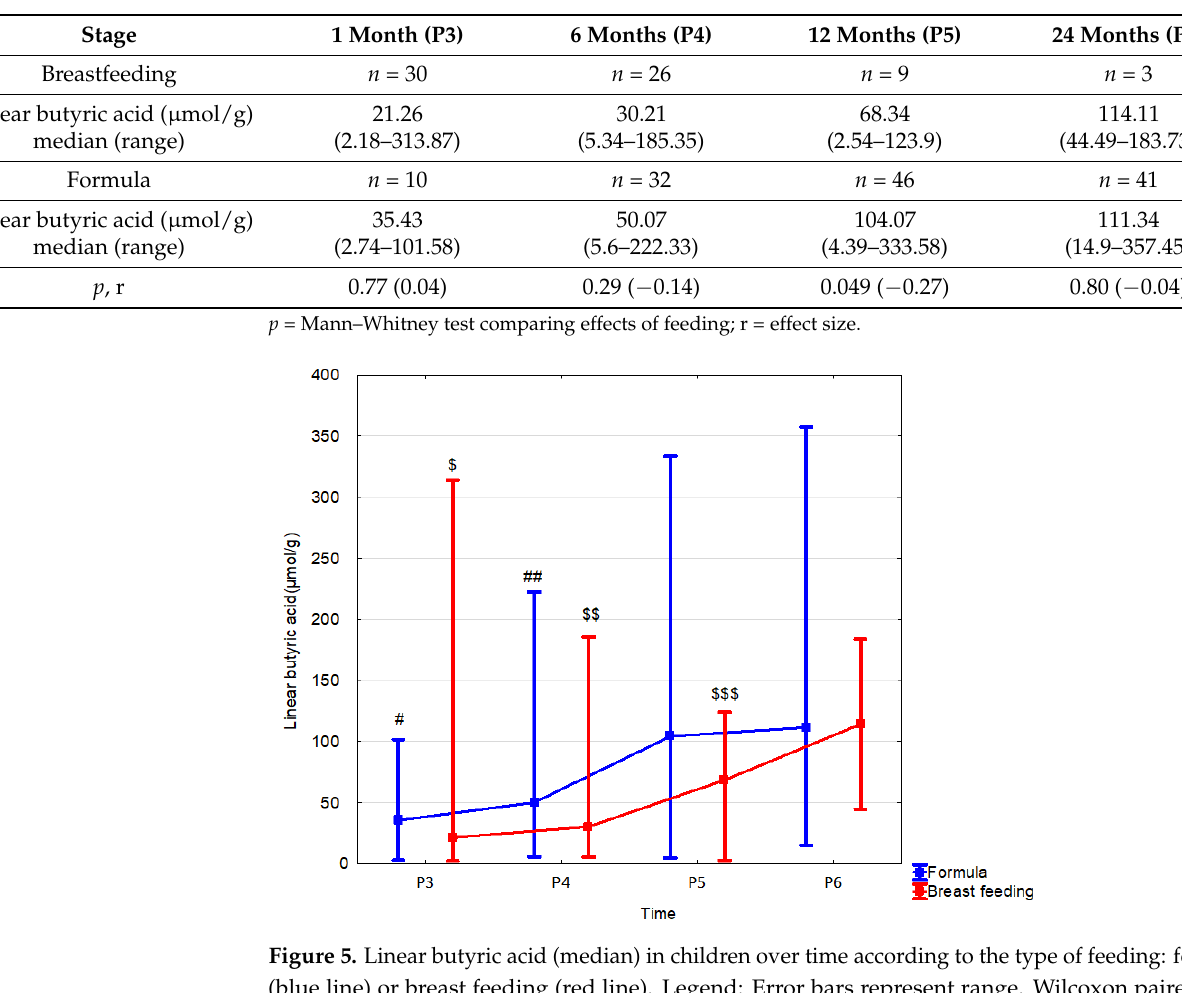
Table 6. Effects of feeding type on linear butyric acid concentration.